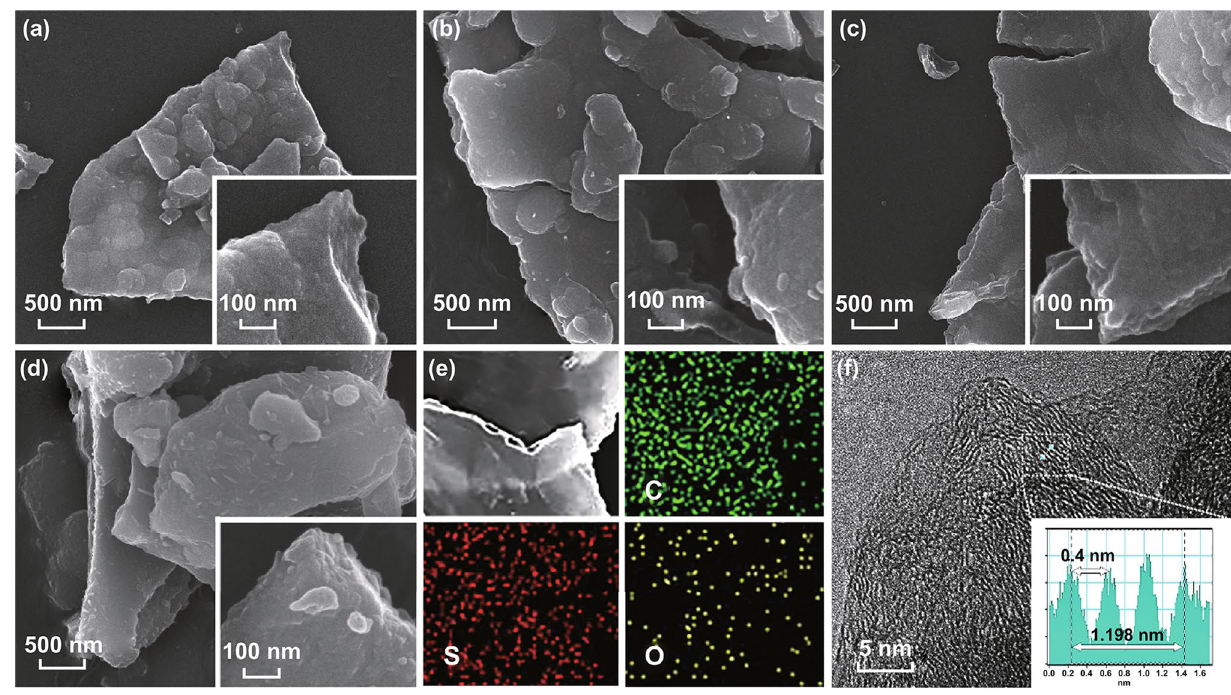
Fig. 1 SEM images of a SC-600, b SC-700, c SC-800, and d SC-900. The insets show the corresponding magnified SEM images. e EDS ele- mental mapping of SC-800. f HRTEM image of SC-800. The inset shows the average interlayer distance at the electronic